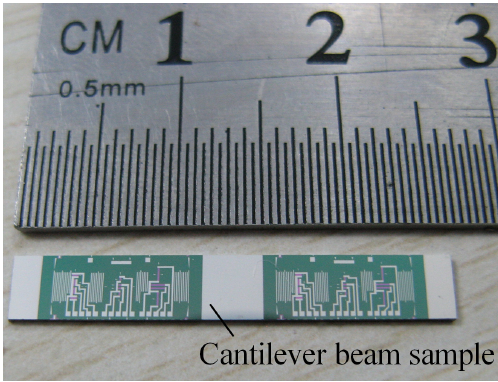
Figure 4. Photograph of an actual cantilever beam sample.